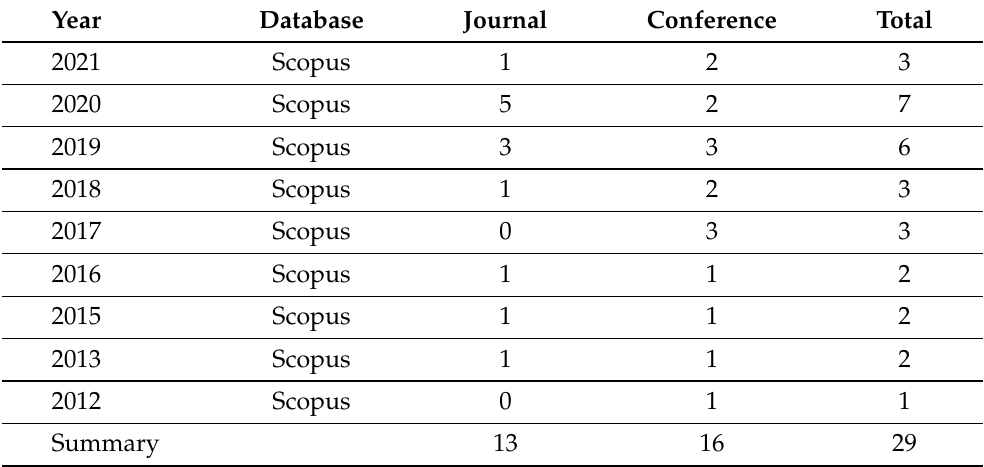
Table 1. Literature Search